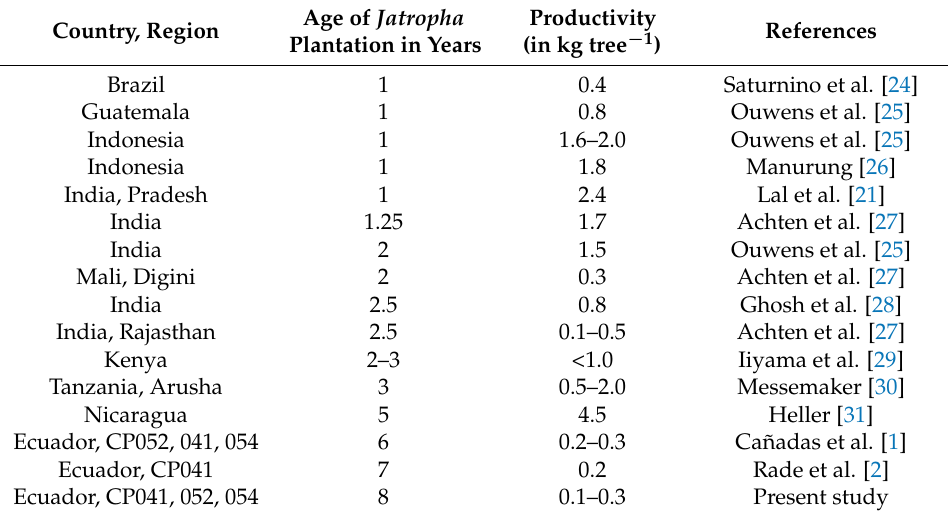
Table 4. Published data for seed productivity of jatropha plantations from different countries. Age of Jatropha Country, Region Plantation in